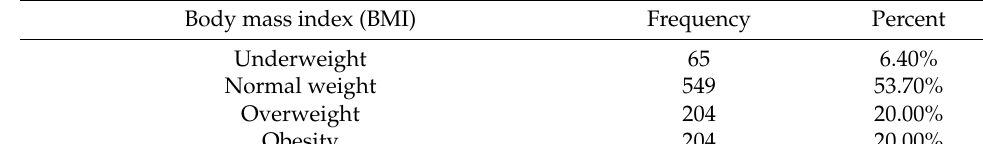
Table 1. Characteristics of the study